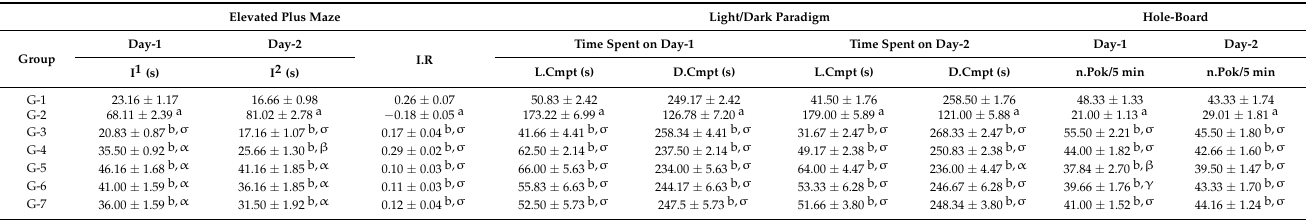
Figure 2. GC ‐ MS analysis of P. anisum active fraction (P.aAF). Figure 2. GC-MS analysis of P. anisum active fraction (P.aAF). Table 3. Effect of P.aAF on enhancement of memory and learning